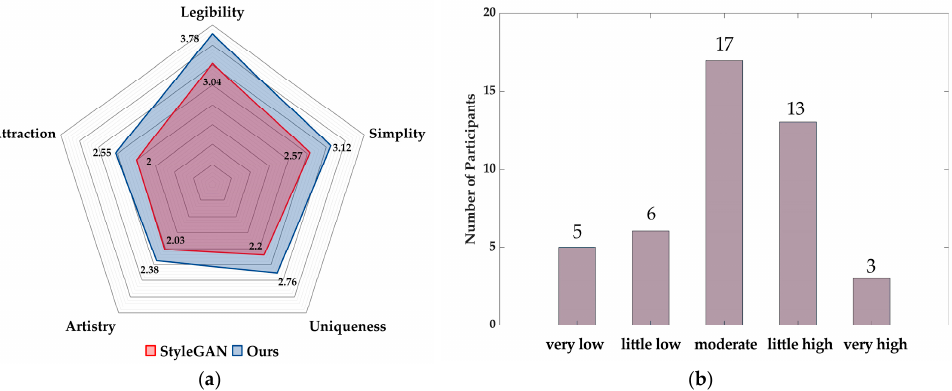
Figure 9. ( a ) Comparison of StyleGAN and ours evaluations; ( b ) Results of the survey on the usefulness of generating icons for design work.